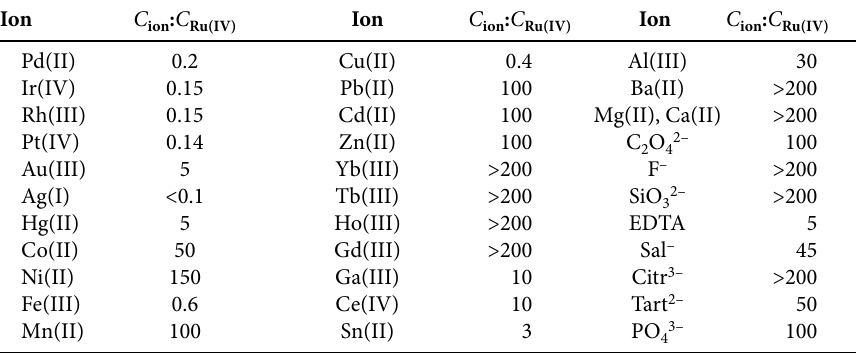
Table 2. Tolerance limits of foreign ions in Ru(IV) spectrophotometric determination using HITO ( C (HITO) = 8.0 × 10 –4 mol L –1 ; C (Ru(IV)) = 2.0 × 10 –5 mol L –1 ; C (NaCl) = 0.1 mol L –1